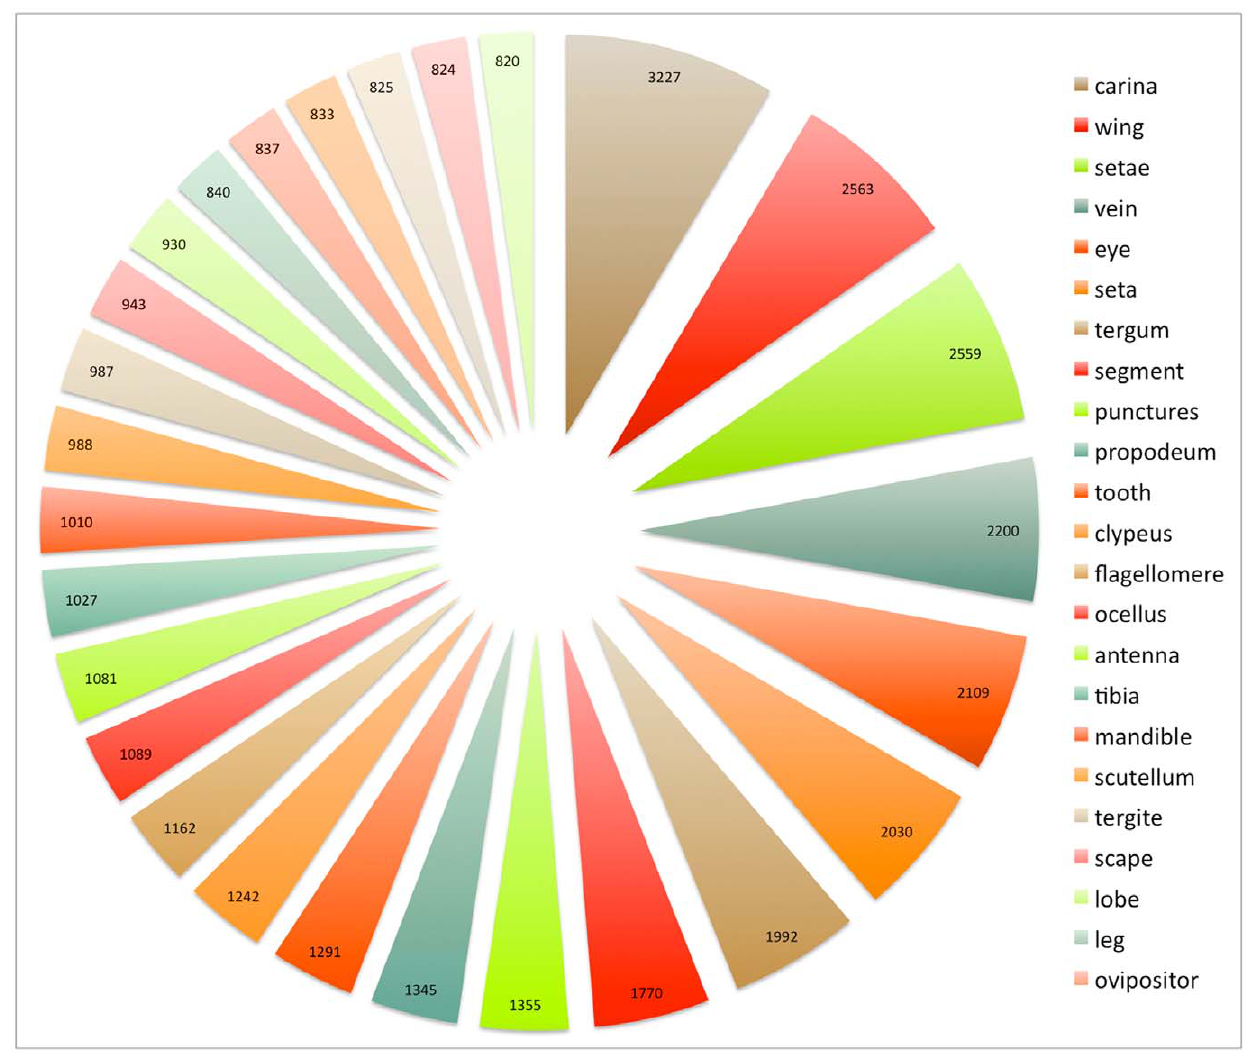
Figure 2. Most commonly used anatomical terms in Hymenoptera. Terms in this figure are ranked based on occurrence among all articles (how many articles a term occurred). Number on chart and size of pie represents the number of total times the term occurred in all